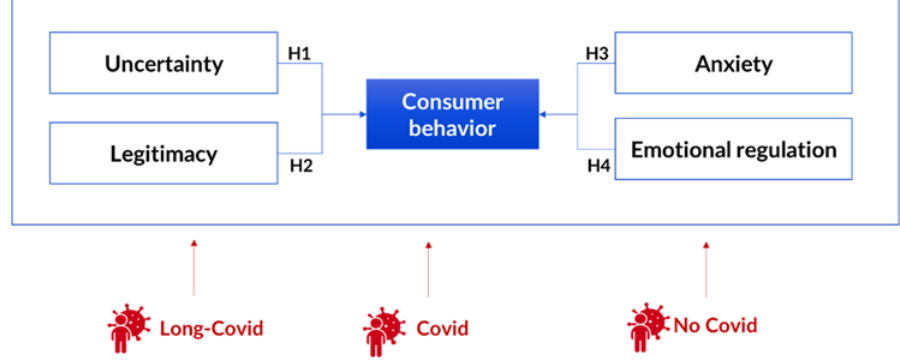
Figure 1. Theorical model and hypothesis. Source: own elaboration.